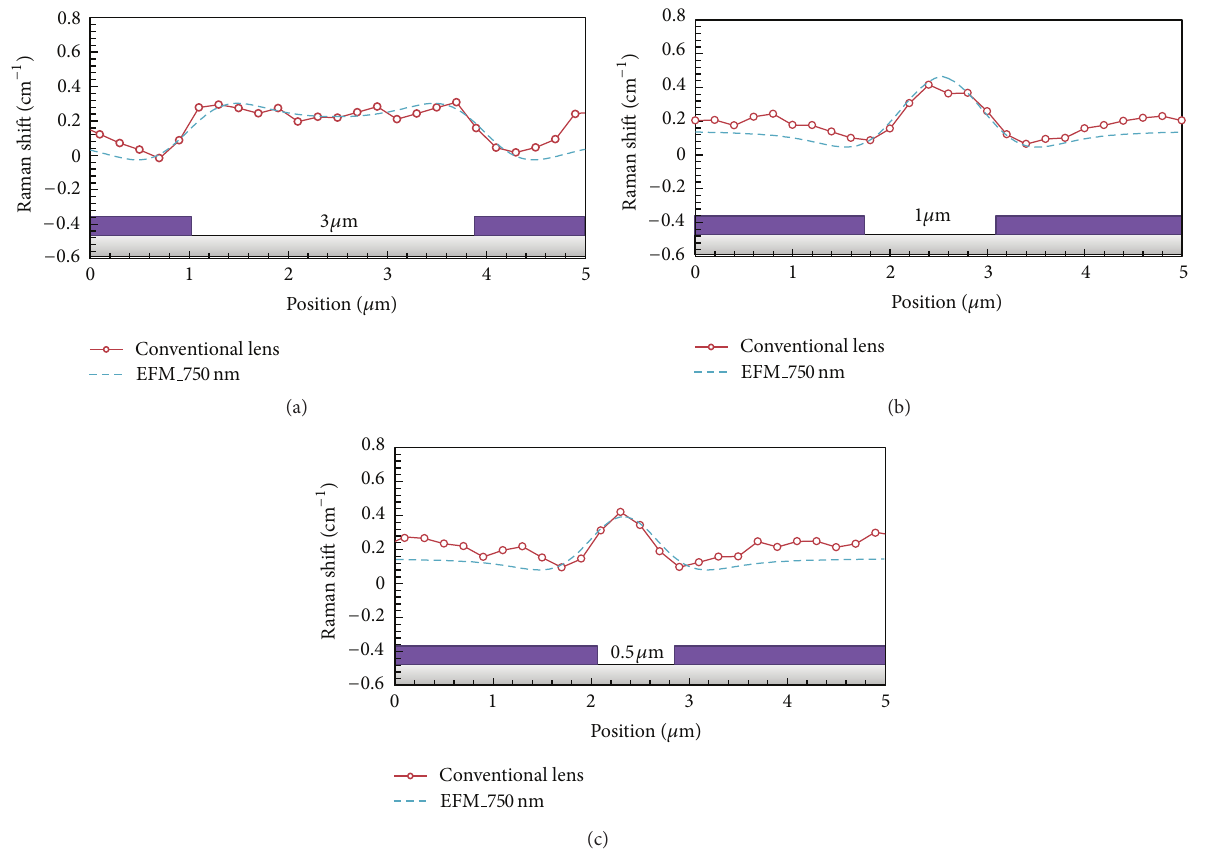
Figure 4: One-dimensional profiles of Raman shifts in the center of L&S pattern obtained by the Raman spectroscopy and EFM calculation with conventional lens (in space widths of (a) 5, (b) 3, and (c) 1 𝜇 m). film (with space widths of 3, 1, and 0.5 𝜇 m). Solid and